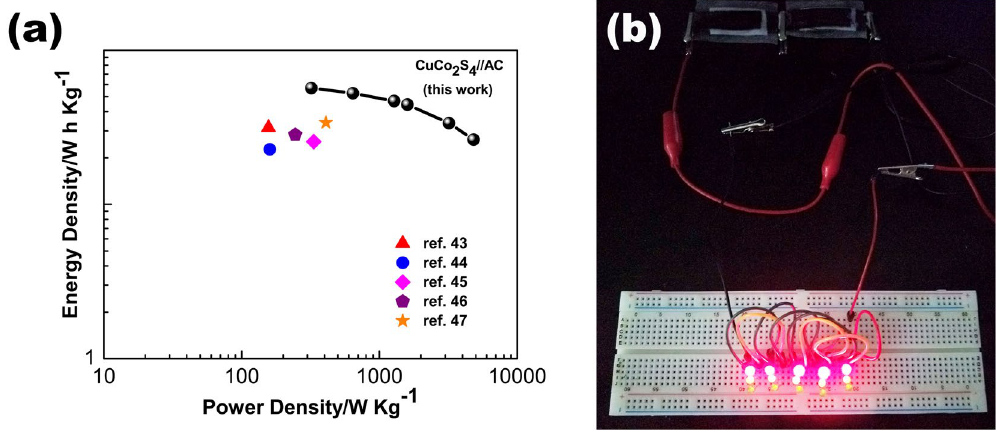
Figure 7. ( a ) Ragone plot of the CuCo 2 S 4 NRAs//AC ASC, ( b ) two ASC devices connected in series can light up 15